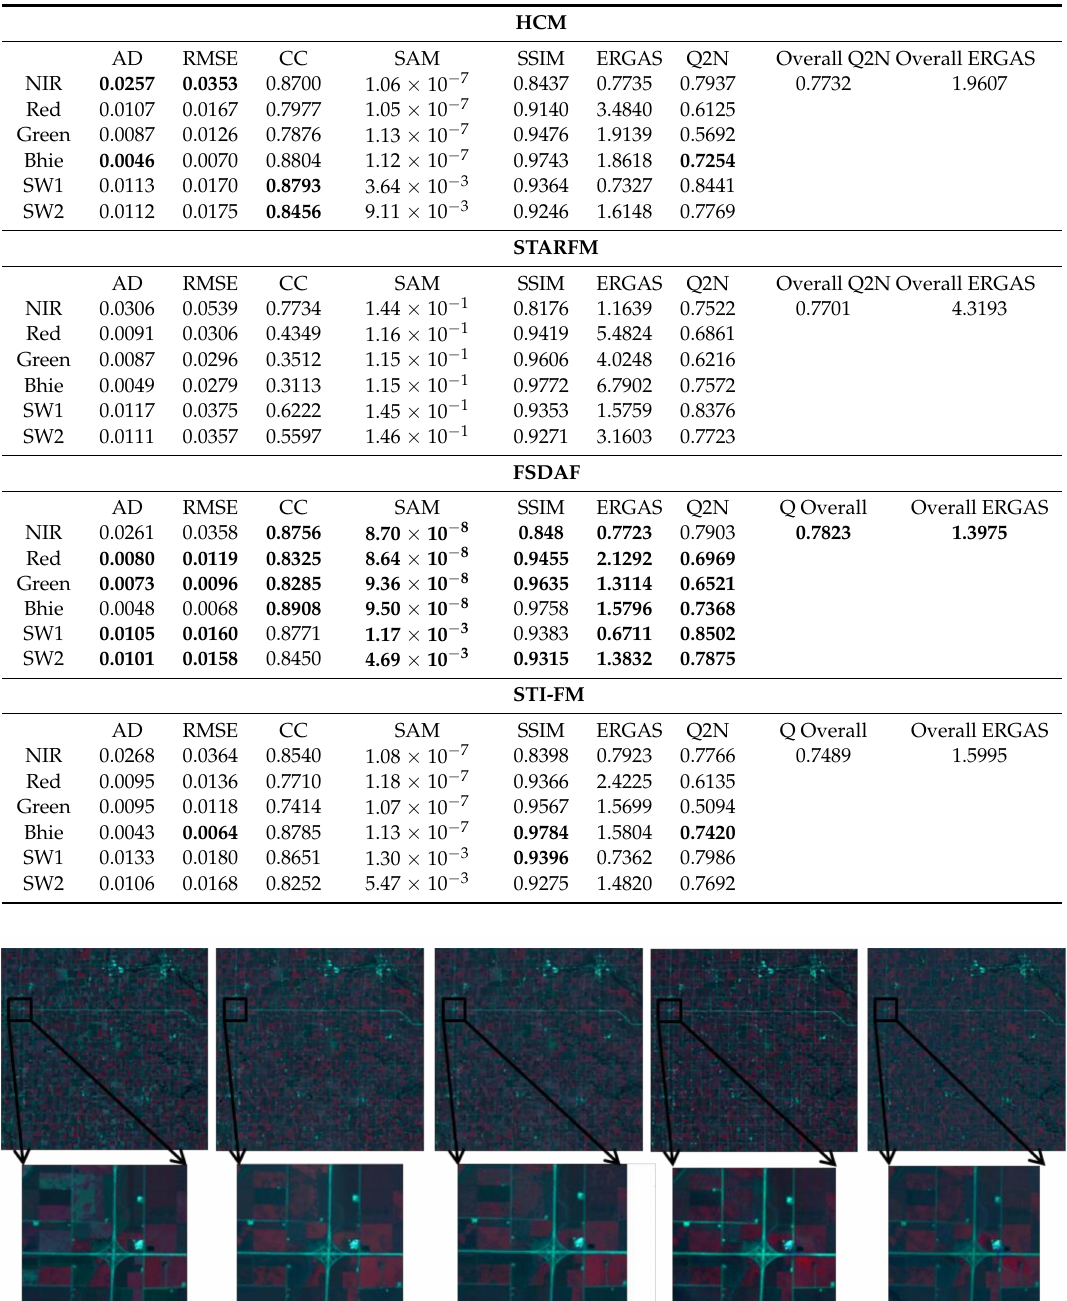
Table 6. Comparison of forward prediction results of using Landsat image 214 to predict Landsat image 246.